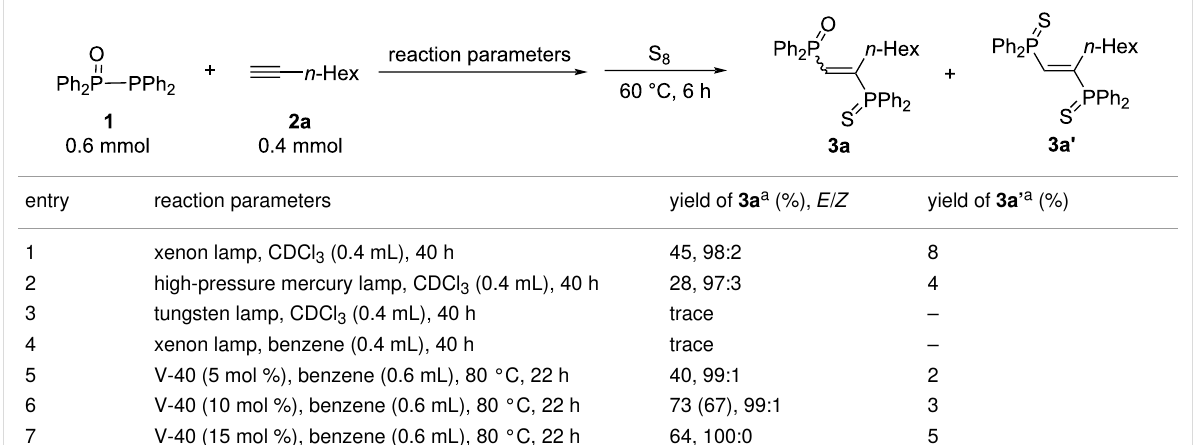
Table 1: Phosphinylphosphination of terminal alkyne 2a with 1 under different reaction